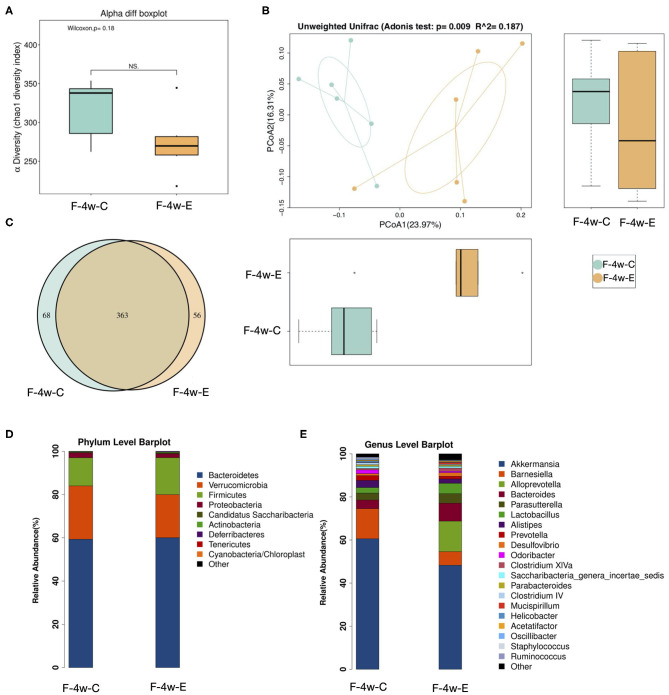
Sequencing analysis of the fecal microbiota obtained from ligatured and no treatment mice 4 weeks after ligation. (A) Diversity of bacterial species as indicated by Chao1 rarefaction measure. Each box plot represents the median, interquartile range, minimum, and maximum values. (B) PCoA of fecal microbiota from ligatured and no treatment mice. (Unweighted distance: R2 = 0.187, p = 0.009 < 0.01, Adonis test). (C) Venn analysis of bacterial OTUs composition between two groups (n = 6). (D–E) Proportional taxonomic assignments at the phylum level and genus level in stool samples from two groups. Only genus detected at mean relative abundance top 20 are presented. OTUs, operational taxonomic units; ANOSIM, analyses of similarities; PCOA, principal coordinates analysis; F-4w-E, experimental periodontitis group; F-4w-C, control group.